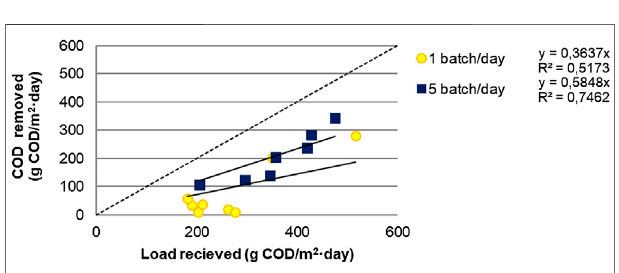
FIGURE10| EffectsoffractionationoftheHLonCODremovalef fi ciency (HL (cid:2) 5.6 cm/day) (temperatures between 5 – 10 ° C).